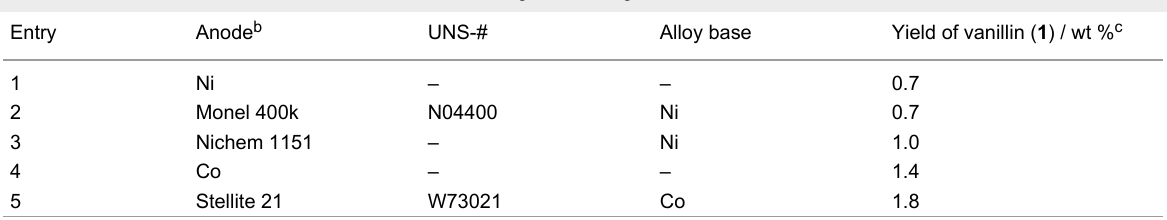
Entry Anode b UNS-# Alloy